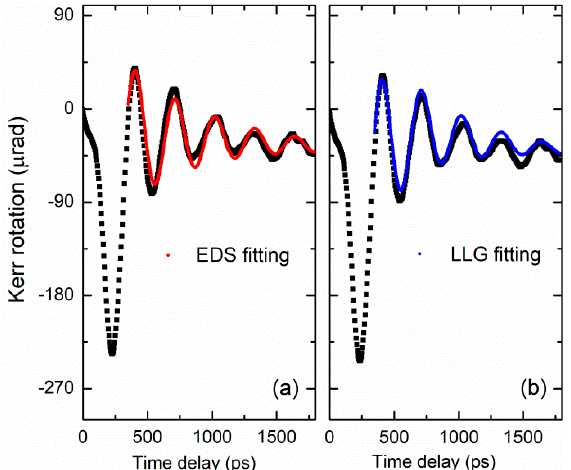
Figure 1. (Color online) Temporal profile of Kerr rotation excited by linearly-polarized pump beam at 1.58 eV with an excitation intensity of 10.9 µ J/cm 2 for the annealed (Ga,Mn)As sample. ( a ) The solid line (red color) shows the best fit by an exponentially-damped sine function. ( b ) The solid line (blue color) shows numerical fitting result to LLG equation. The initial pulse-like-signal persists to above the Curie temperature, and is associated with non-equilibrium electron–hole pairs in the GaAs substrate. The fitting is focused on the oscillatory part of the Kerr rotation, which represents a uniform precession of magnetization in the (Ga,Mn)As film [21].